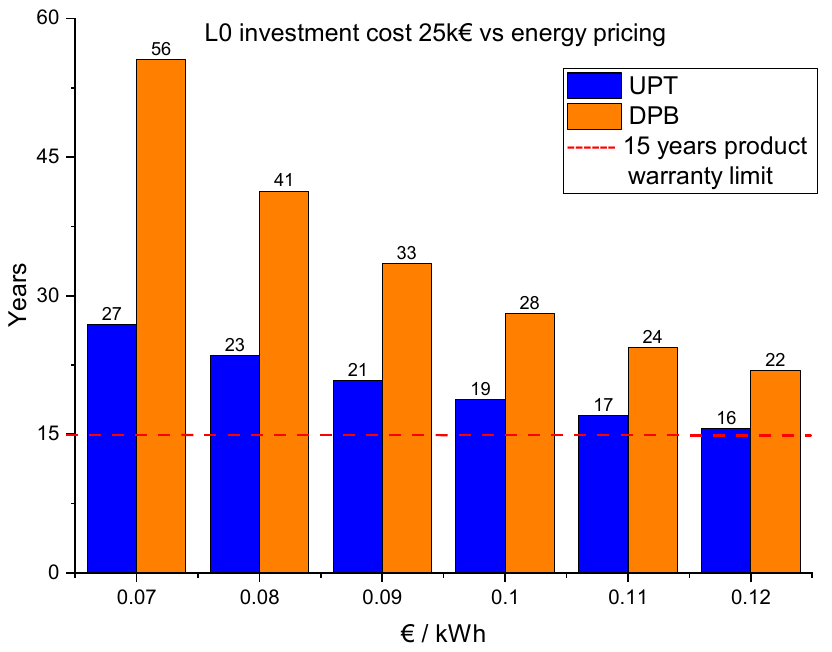
Figure 23. Different payback times: UPT and DPB (D% = 3%) of LEF investment. Table 8. Energy price per kWh and corresponding energy savings in Euro for CB0 and CL0. Energy Price ( €